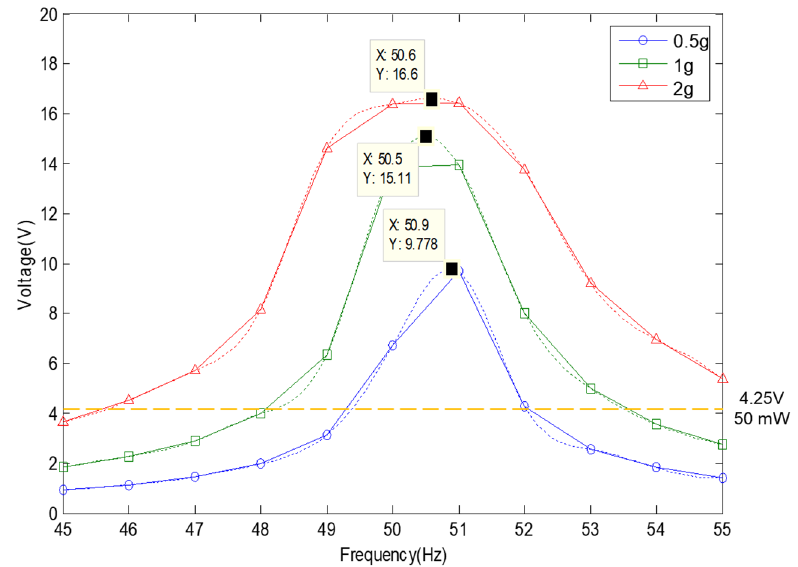
Figure 13. The RMS generated voltage with a 360 Ω load resistance (V rms-veh ) according to the vibration acceleration at one lower coil of the VEH device. A resonant frequency of 50 Hz was used under 0.5, 1.0 and 2.0 G vibration acceleration conditions. The thickness of the spring was 1.0 mm. The maximum moving displacement of the spring was 4.0 mm.